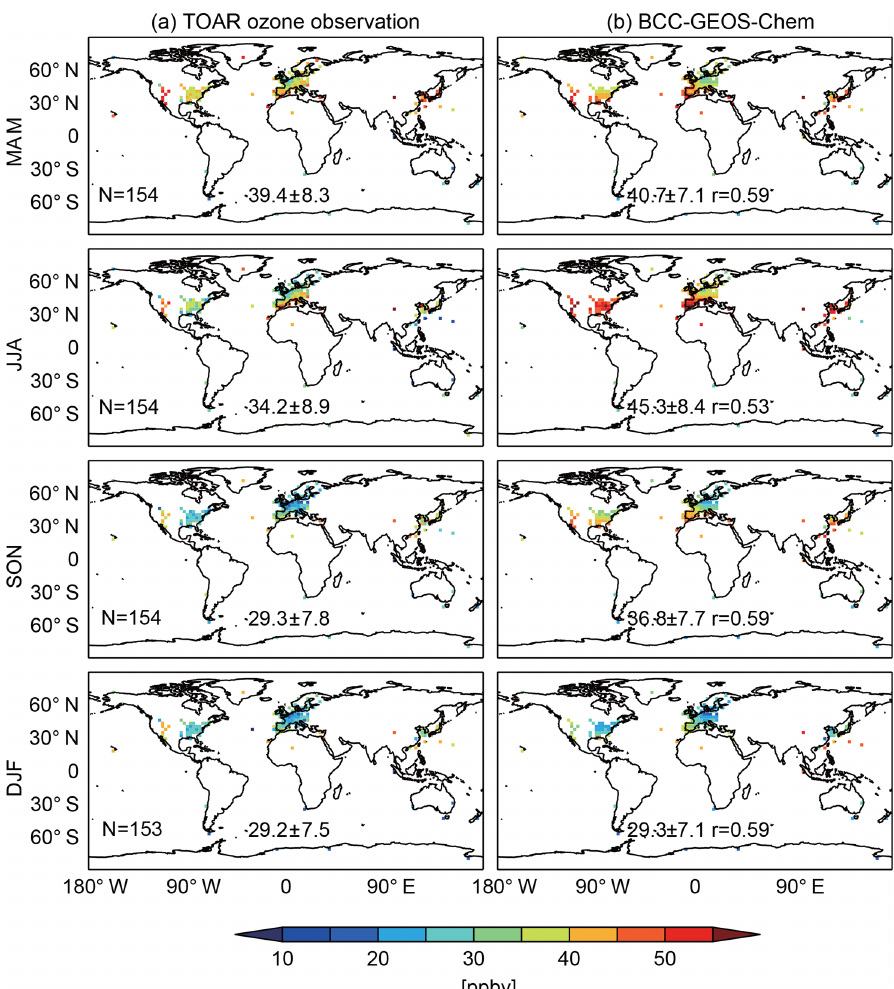
Figure 7. Spatial and seasonal distributions of observed and simulated surface ozone mixing ratios for 2012–2014. The model results (b) are compared to observations at rural/remote sites from the TOAR dataset (a) . Observations are averaged to the same model grid. Seasonal mean values for observations and model results, their spatial correlation coefficients ( r ), and the number of co-sampled grids ( N ) are shown inset.